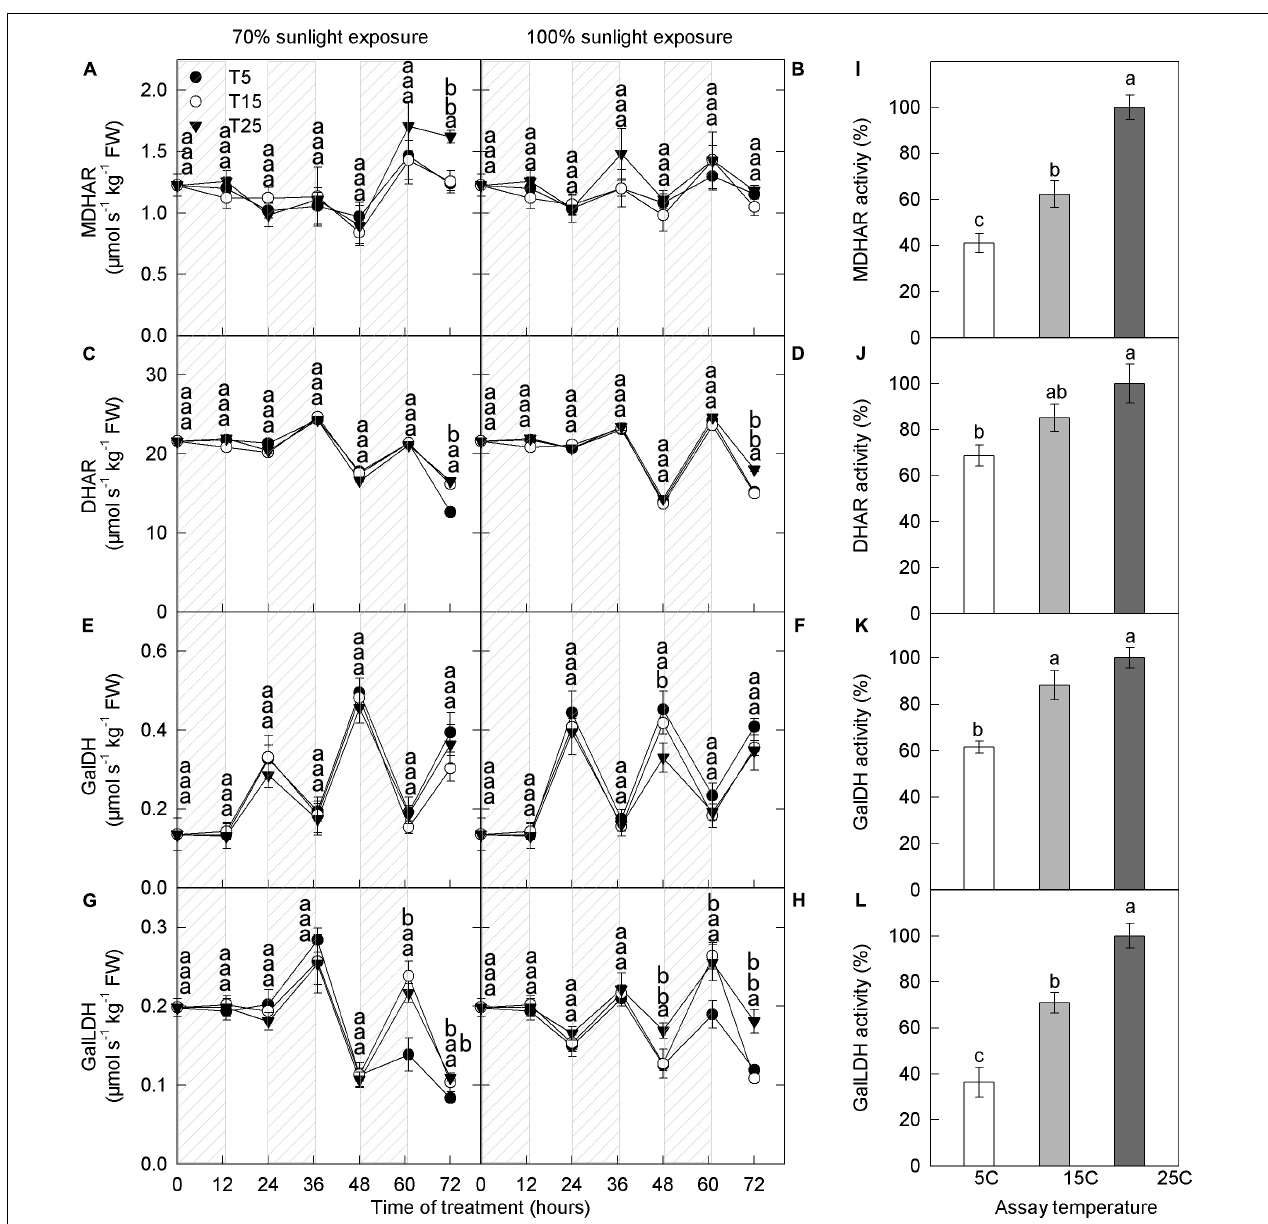
FIGURE 7 | Activities of enzymes related to ascorbic acid metabolism in the peel of “Fuji” apple fruits exposed to different nighttime temperatures and sunlight intensities and measured at different assay temperatures. Enzyme activity of MDHAR (A) , DHAR (C) , GalDH (E) , and GalLDH (G) in the peel of “Fuji” apples exposed to nighttime temperatures of 5, 15, and 25 ◦ C and 70% sunlight intensity. Enzyme activity of MDHAR (B) , DHAR (D) , GalDH (F) , and GalLDH (H) in the peel of “Fuji” apples exposed to nighttime temperatures of 5, 15, and 25 ◦ C and 100% sunlight intensity. Enzyme activity of MDHAR (I) , DHAR (J) , GalDH (K) , and GalLDH (L) in the peel of “Fuji” apples exposed to assay temperatures of 5, 15, and 25 ◦ C. MDHAR, monodehydroascorbate reductase; and DHAR, dehydroascorbate reductase; GalDH, galactose dehydrogenase; GalLDH, galactono lactone dehydrogenase. Different lowercase letters indicate significant difference among treatments at P <